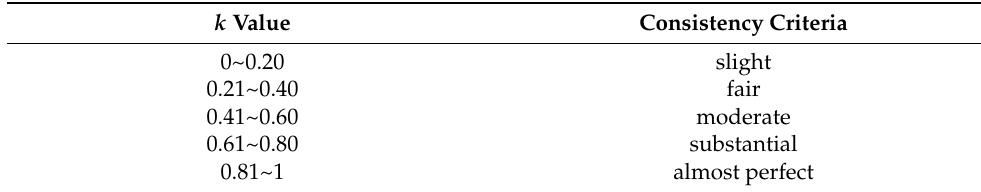
Table 3. The k value consistency classification